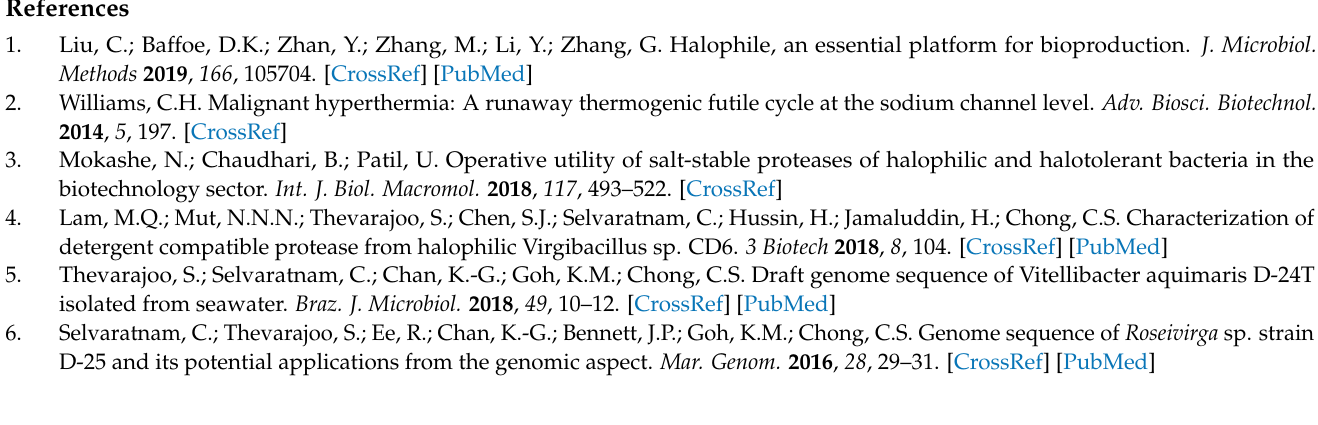
Table S3: Putative horizontal transferred genes of R. solimangrovi related to lignocellulose degradation, inferred from genomic data; Table S4: List of potential genes involved in uptake and metabolism of sugars, inferred from genome of R. solimangrovi